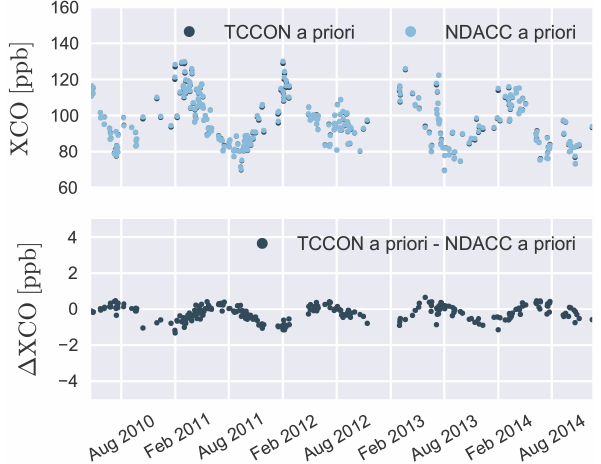
Figure 5. Upper panel: daily mean time series of XCO retrieved from MIR spectra using different a priori VMR profiles; lower panel: the absolute difference time series shows the impact of changing the a priori profiles.